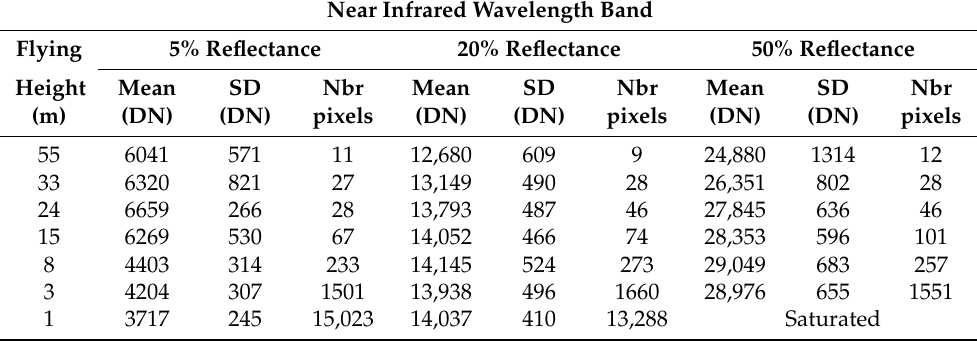
Table 5. Mean pixel values and standard deviation for the reflectance calibration panels at different Figure 15. “Nbr pixels” denotes the number of pixels used to derive mean and standard deviation for the different flying heights.